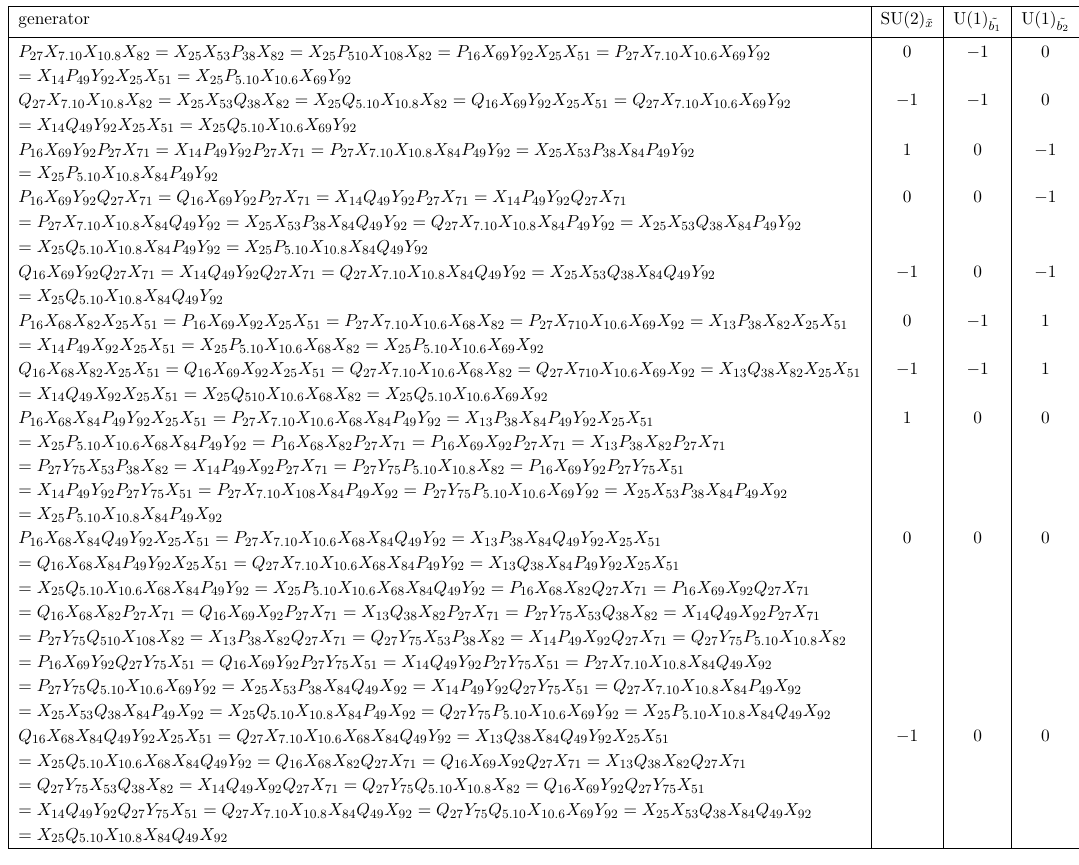
Table 57 . The generators in terms of bifundamental chiral fields for Model 14 (Part 1)